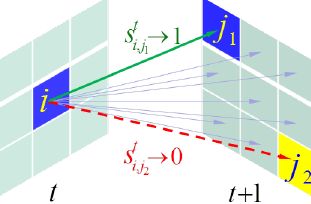
Figure 3. A simple flow model: people in location i at time t can travel to location j ∈ N ( i ) at time t + 1. The green arrow means a strong match with a similarity near to 1; the red dotted arrow represents an impossible match with a similarity close to 0; the gray arrows are possible matches whose similarities are set the same as 0.5.